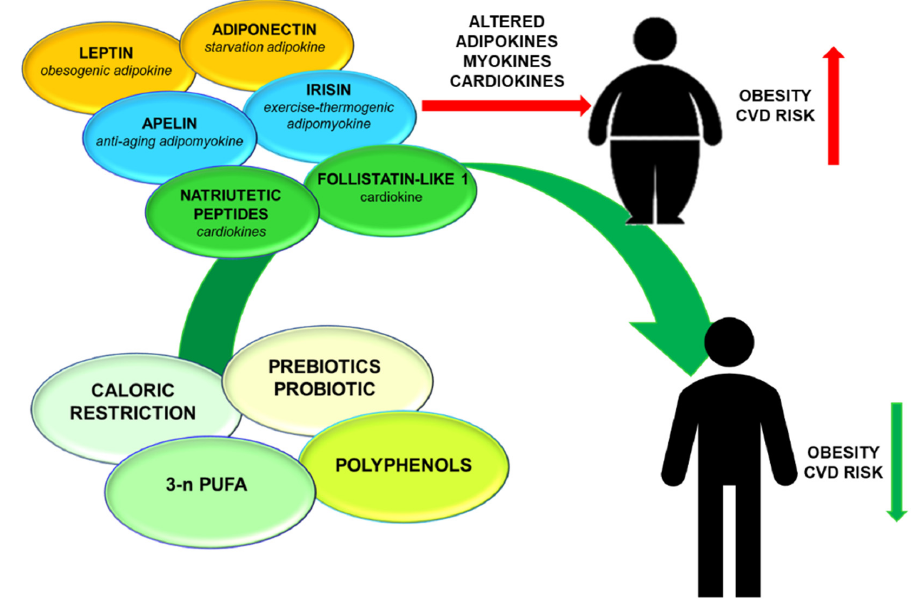
Figure 1. Schematic summary of nutritional interventions on adipokines, myokines, and cardiokines Obesity and consequently cardiovascular diseases are characterized by an altered secretion of adipokines, myokines, and cardiokines. In this review, nutritional interventions (caloric restriction, prebiotic or probiotic supplementation, 3-n PUFA, and polyphenols) having a positive action on these molecules, are described. These nutritional interventions could ameliorate cardiometabolic state in obese subjects.